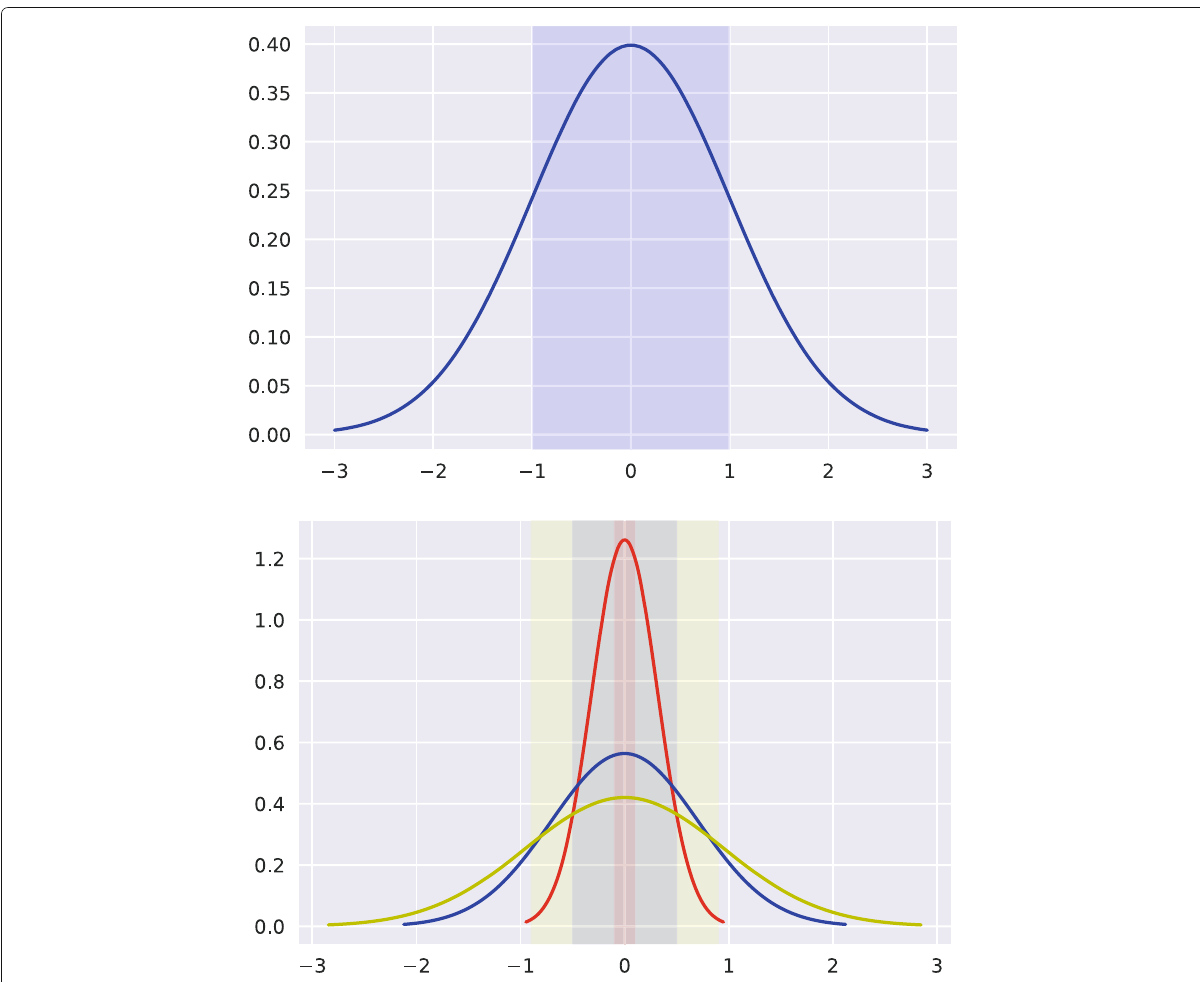
Fig. 2 Top: Defining a target and standard deviation. Bottom: Plot with different targets and standard deviations